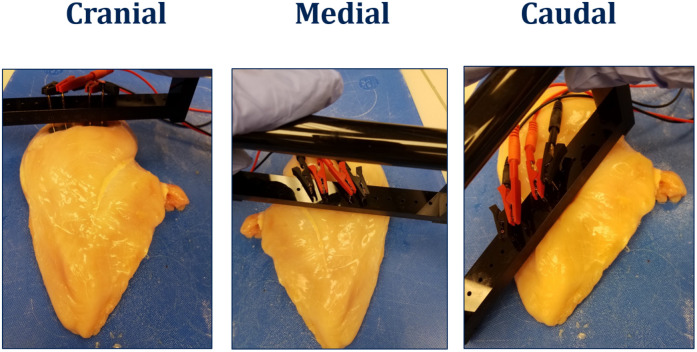
Segmental BIA of breast filets.